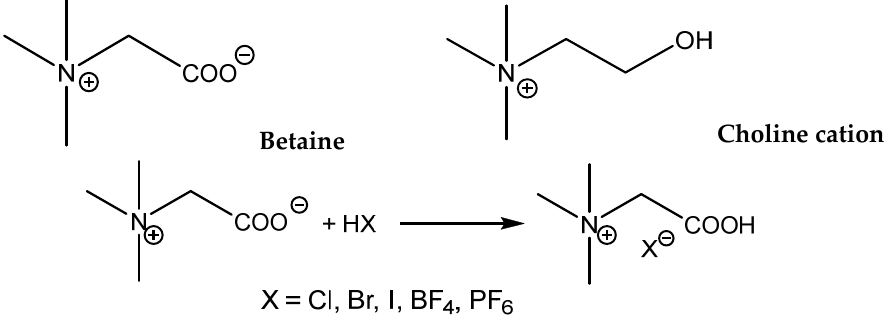
Figure 14. Structure of 1-ethyl-2-(2-hydroxy)ethylpyrazolium bromide, the most effective carbonation catalyst based on 1-alkyl-2-hydroxyalkyl pyrazolium salts [96]. Zhou et al. compared the catalytic activity of quaternized aminoacid glycine (betaine) and quaternized aminoethanol salts (choline salts, Scheme 12) [97].